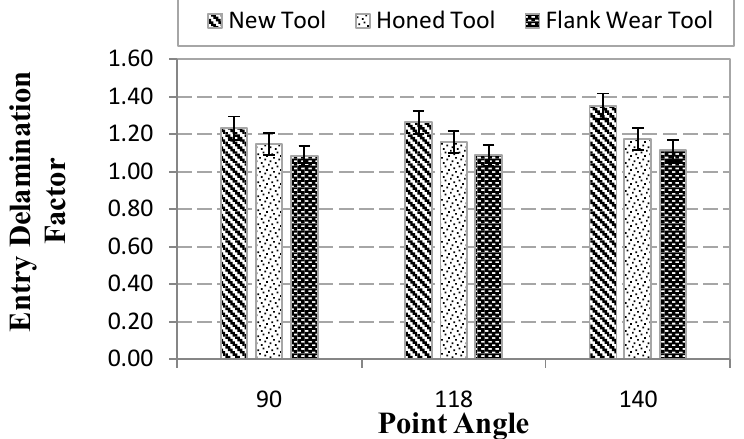
Figure 7. Maximum delamination at hole entry (measurement variations are indicated including error